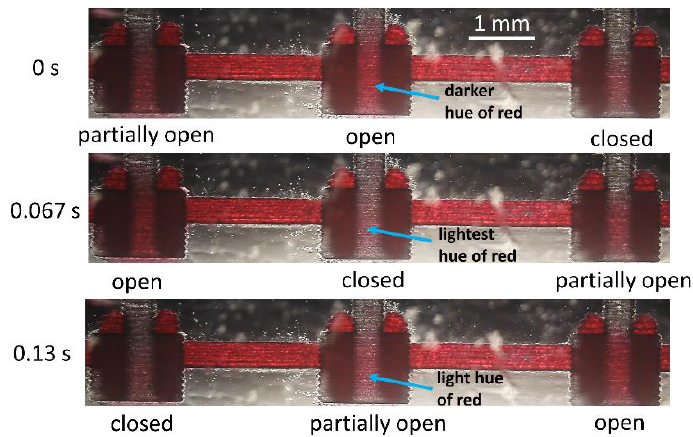
Figure 8. Oscillator driving three valves in series out-of-phase in a fluid line. The three phases are open, closed, and partially open. When partially open, a small volume of red-dyed water enters the flow chamber. In the open phase, the chamber is maximally filled with the water, imparting it a darker red hue. Valve closing evacuates the chamber indicated by the minimally red color (Multimedia view).